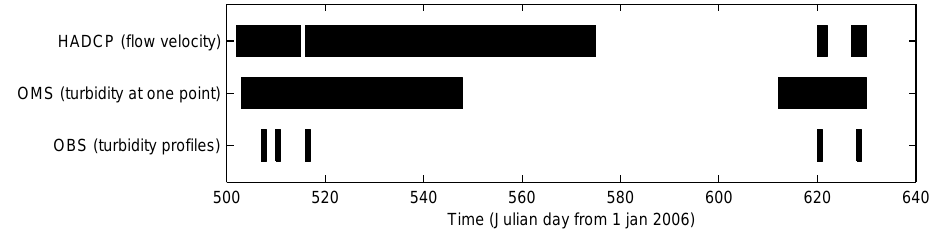
Fig. 4. Timeline per instrument of the measurements used in this